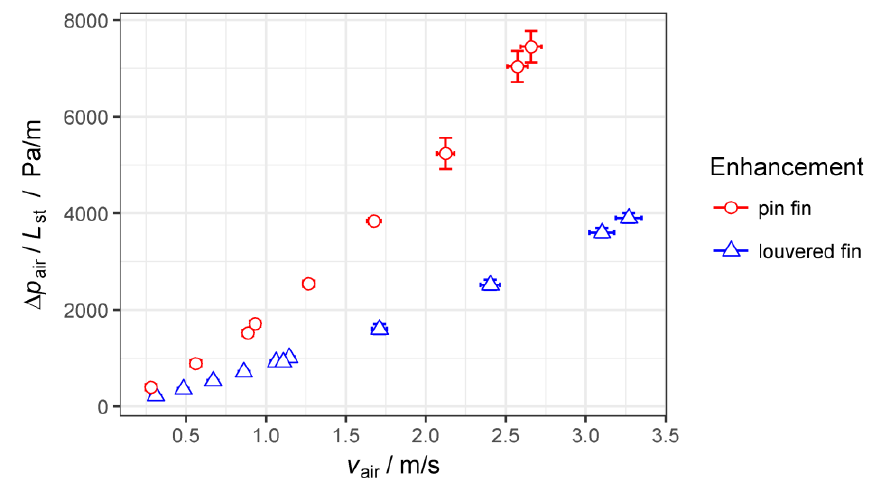
Figure 10. Pressure drop Δ𝑝 air normalized with length of structure 𝐿 st versus air velocity 𝑣 air for louvered and pin fins; error bars for expanded uncertainty.